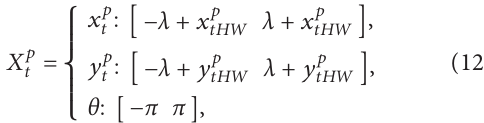
Figure 1. For detailed algorithm, we refer the reader to Seyedali’s